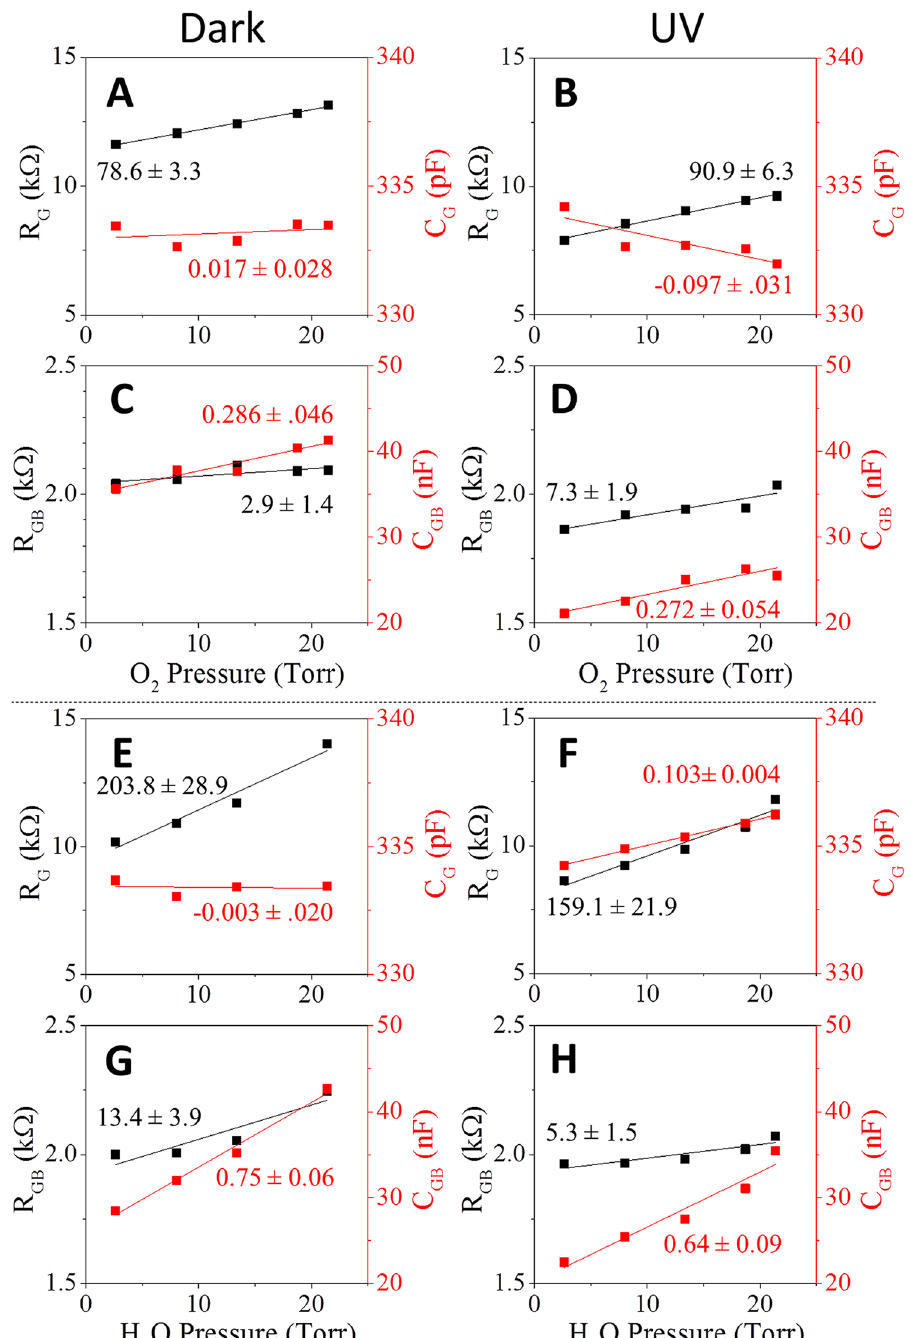
Figure 5. Contributions of the response to pressure from the grain resistance (R G , black) and grain capacitance (C G , red) to O 2 ( A , B ) and to H 2 O ( E , F ); and from the grain boundary resistance (R GB , black) and grain boundary capacitance (C GB , Red) to O 2 ( C , D ) and H 2 O ( G , H ) in dark conditions and under UV irradiation, indicate that the R G and C GB slopes exceed the R GB and C G slopes in all cases – i.e., the resistive and capacitive responses are dominated by the grain resistance and boundary